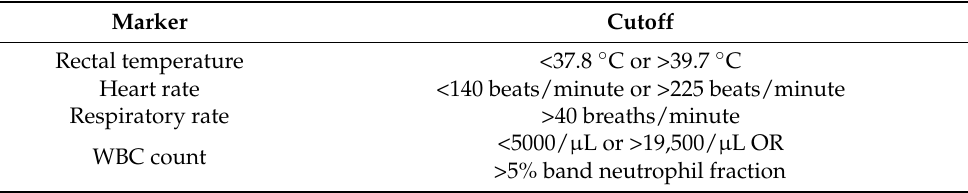
Table 1. Markers and cut-off values for systemic inflammatory response syndrome (SIRS ≥ 3/4 markers). Marker Cutoff Rectal temperature <37.8 ◦ C or >39.7 ◦ C Heart rate <140 beats/minute or >225 beats/minute Respiratory rate >40 breaths/minute <5000/ µ L or >19,500/ µ L OR WBC count >5% band neutrophil fraction According to Brady et al., 2000 [10].